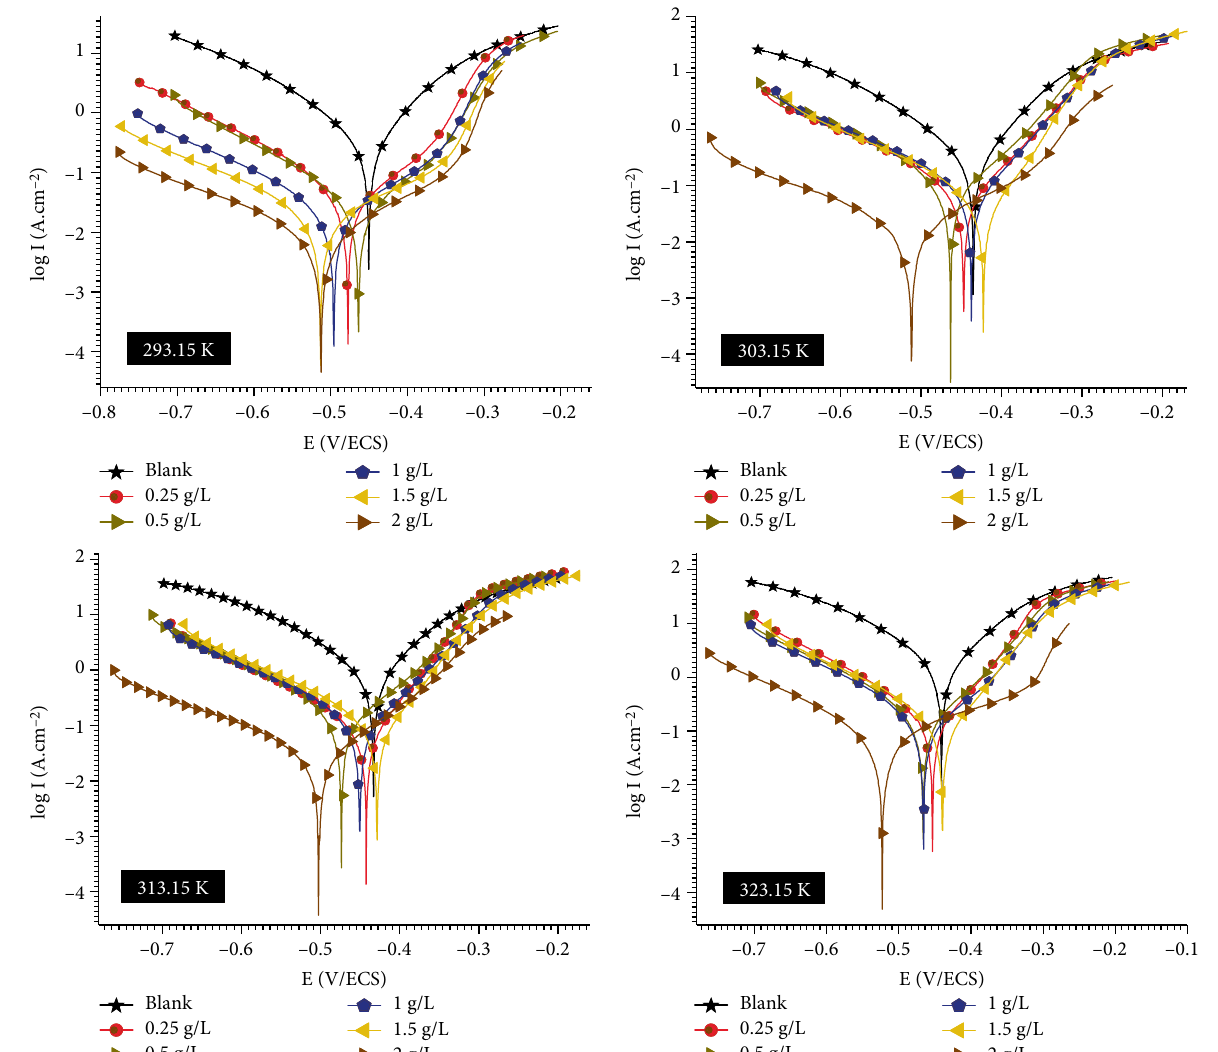
Figure 2: Effect of temperature on the cathodic and anodic curves of C38 steel in 1 M HCl with different concentrations of